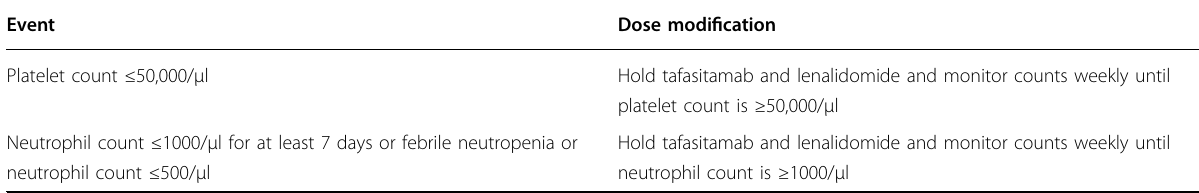
Table 3 Dose modi fi cations for tafasitamab and lenalidomide hematologic toxicities.